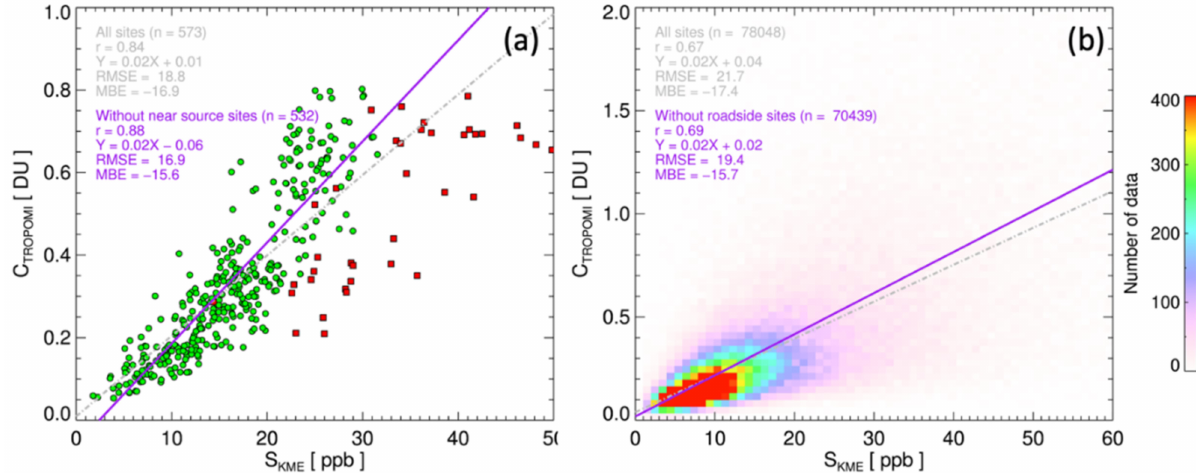
Figure 5. Comparison of tropospheric column NO 2 from TROPOMI and in-situ surface mixing ratio from KME network over South Korea for 2019. Panel ( a ) compares annual mean values at KME stations, and panel ( b ) compares all collocated samples. Green circles in panel ( a ) represent ambient monitoring stations and red rectangles indicate roadside